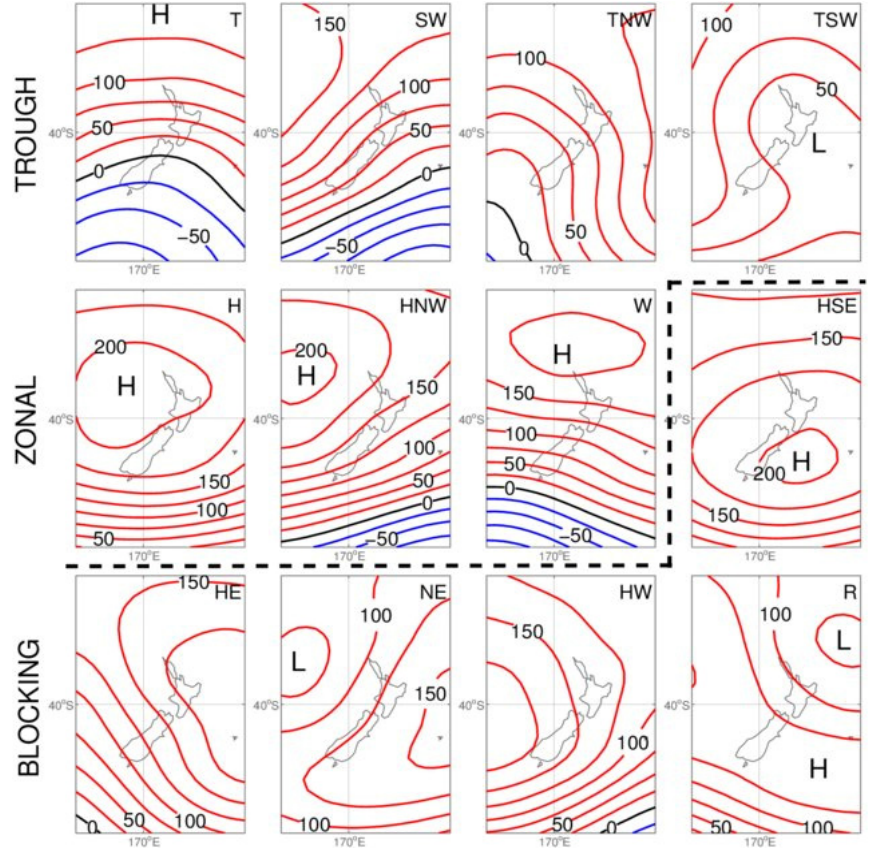
Figure 3. The twelve Kidson weather types, shown as average patterns of 1000 hPa geopotential height (analogous to mean sea-level pressure). Contours mark 1000 hPa geopotential height anomaly in hPa. Names for the types are indicated in the top right of each panel. Source: Ackerley, et al. [35] distributed under the Creative Commons Attribution 3.0 License. The three regimes are indicated at the left: the top row is the trough regime, the first three in the second row are the zonal regime, and the rest form the blocking regime. See Kidson [29] for further details.